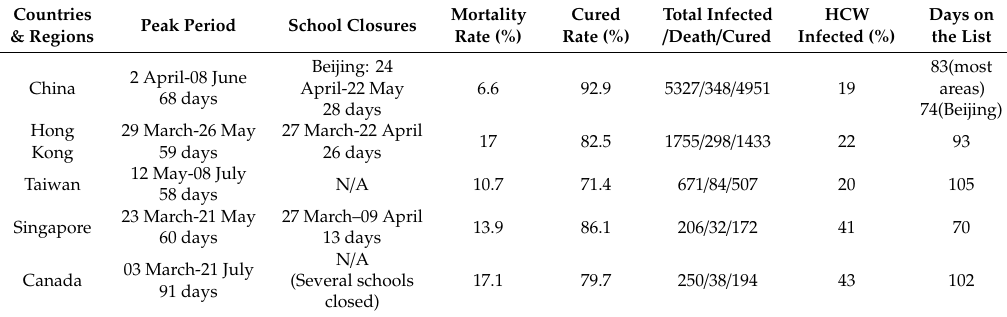
Table 7. Statistical analysis of the SARS